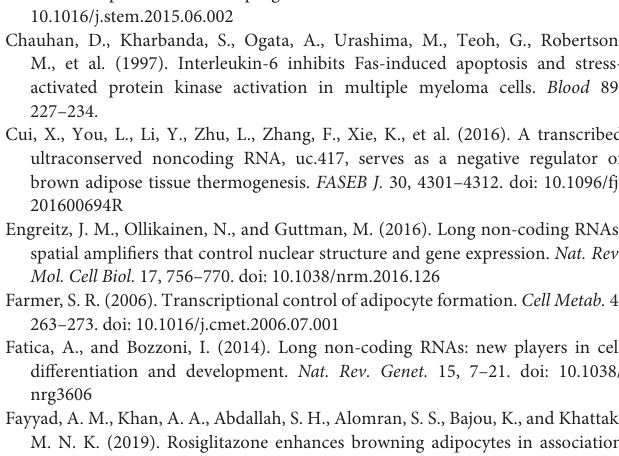
Supplementary Figure 2 | The expression levels of Lnc-FR265215 and Lnc-FR067374 in various of tissues. (A) The expression level of Lnc-FR265215 in various tissues of the mouse by qRT-PCR. (B) The expression level of Lnc-FR067374 in various tissues of the mouse by qRT-PCR. All data are expressed as the mean ± SEM, N =